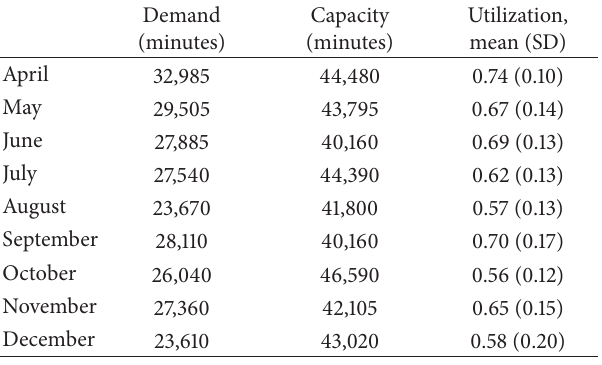
Figure 2: Histogram of daily resource